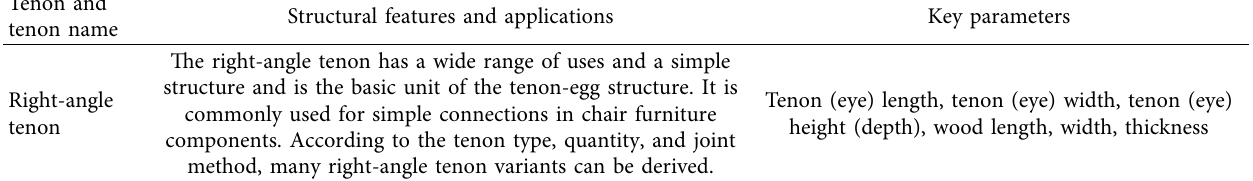
Table 4: Features and applications of common tenon and tenon